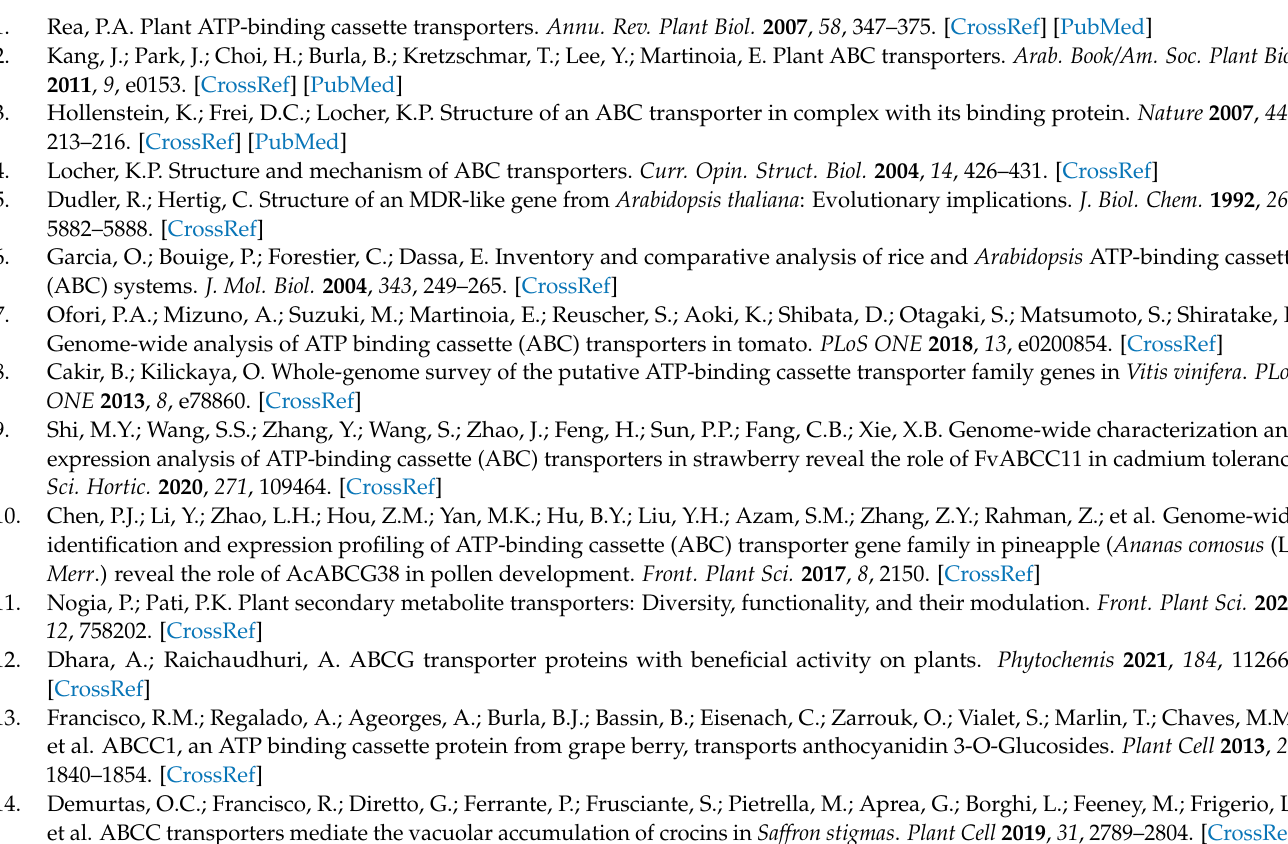
Table S2. Statistical analysis of the VIGS TcLr19